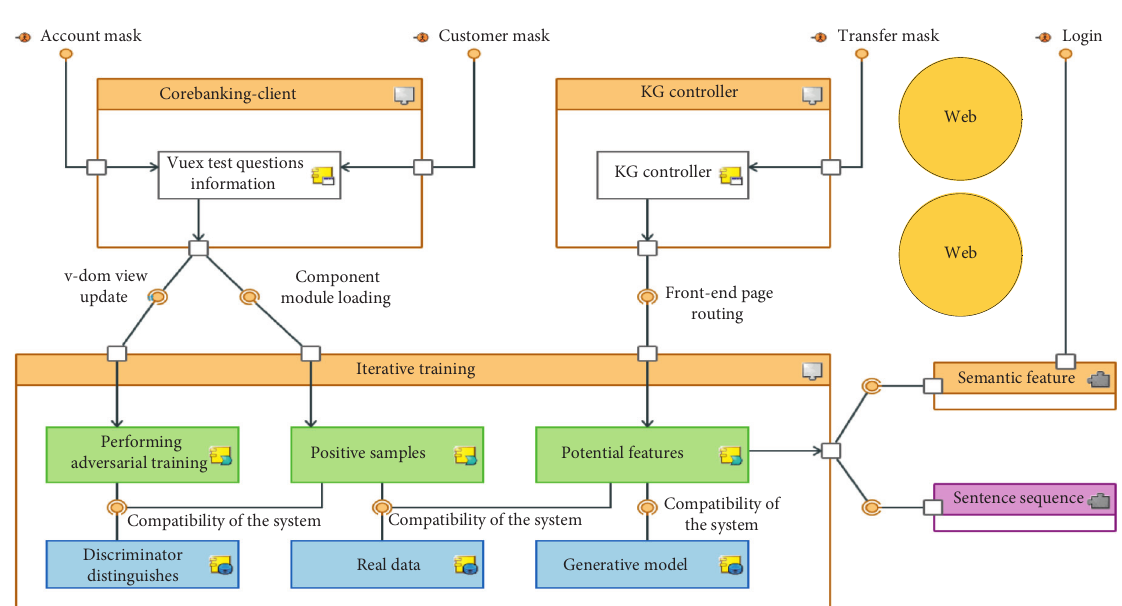
Figure 2: Path connection operation in